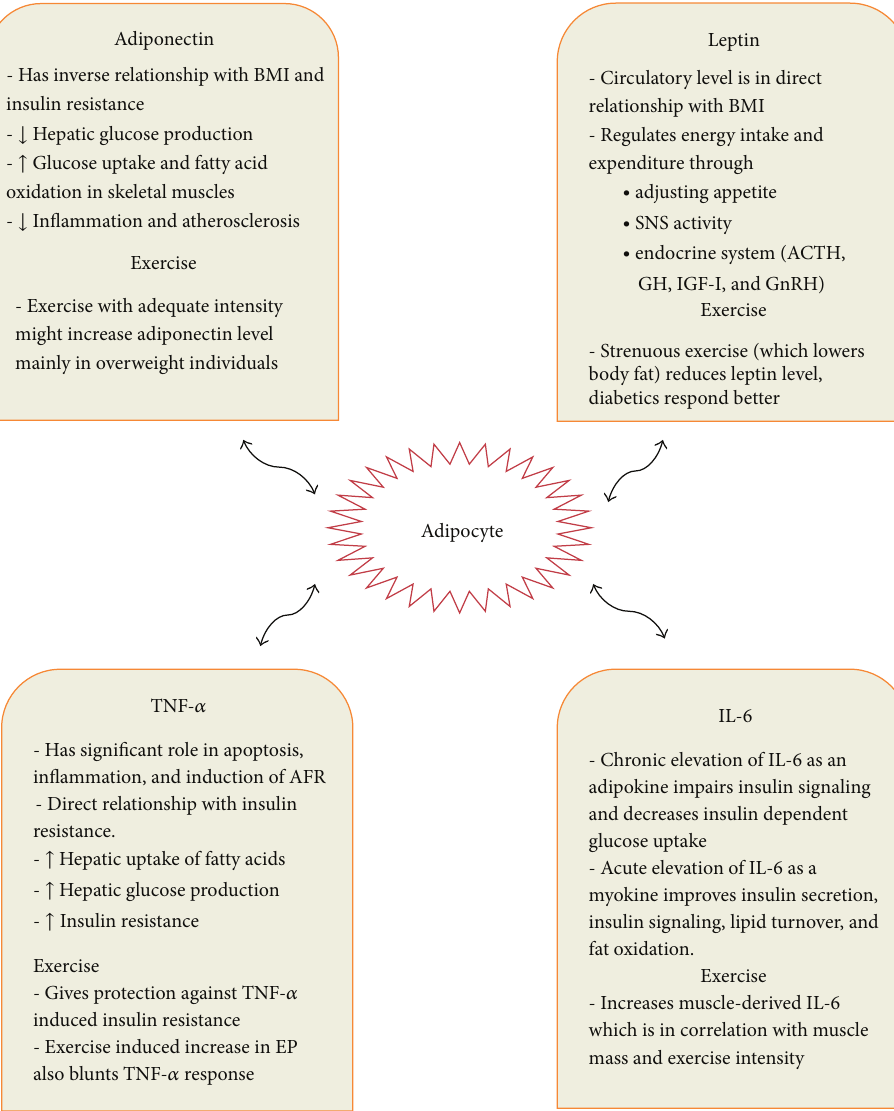
Figure 2: Selected physiologic effects of four adipokines and the effect of exercise on their blood